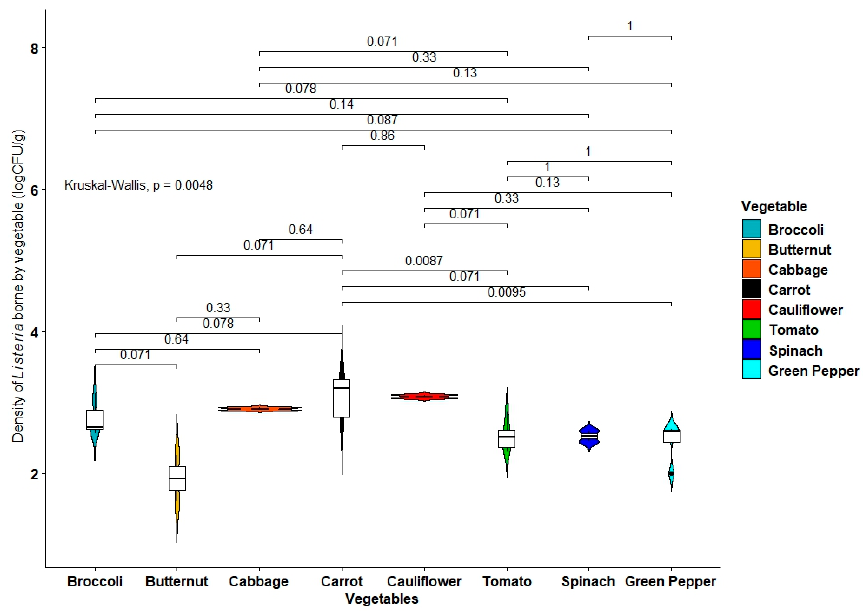
Figure 1. Distribution of presumptive Listeria species in vegetable samples.